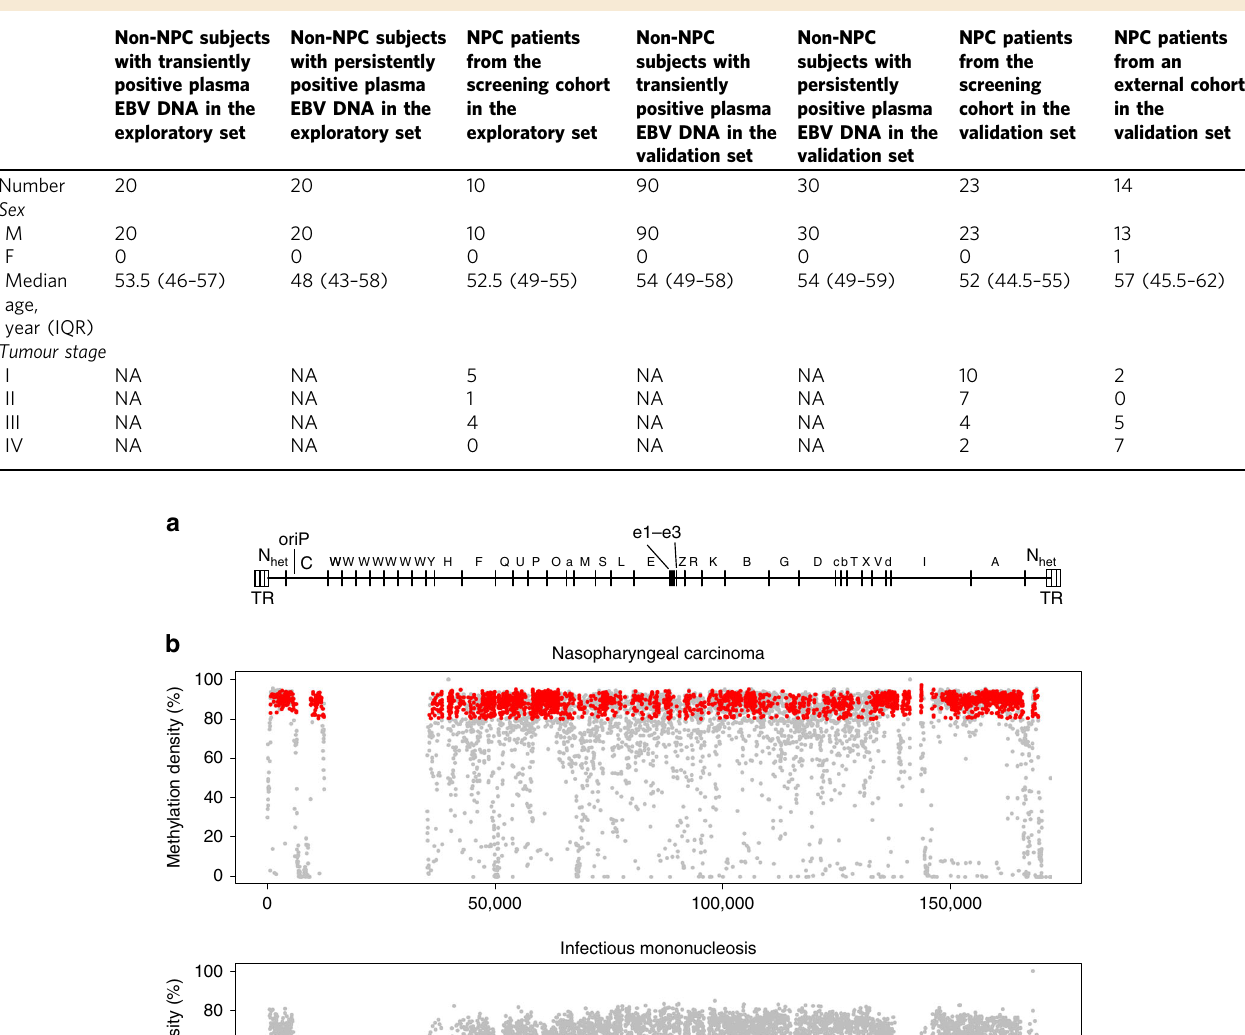
Table 1 Subject characteristics in the exploratory and validation sample sets Non-NPC subjects with transiently positive plasma EBV DNA in the